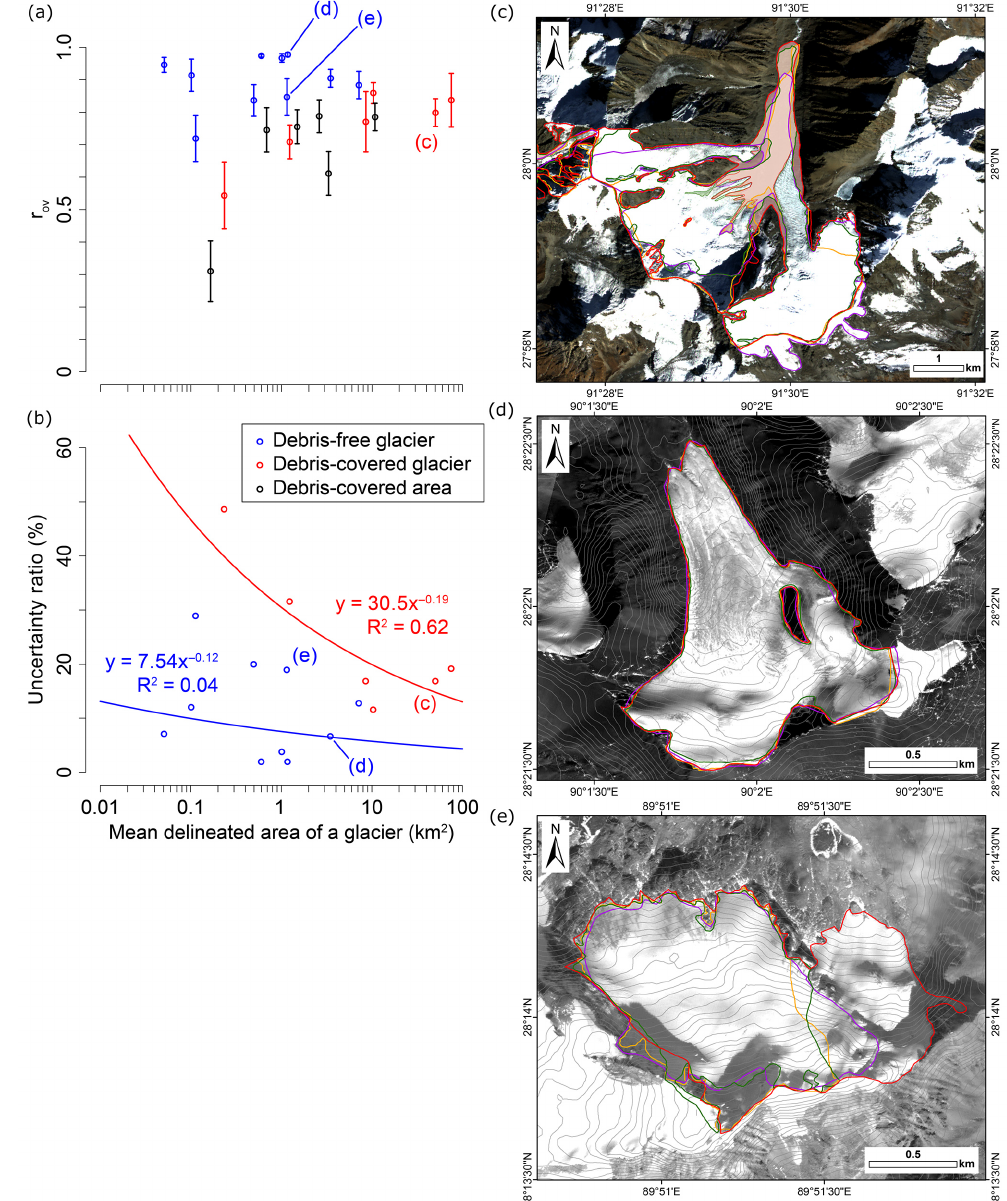
Figure 7. Validation of manual glacier delineation using ALOS imagery. (a) Mean values of r ov and their standard deviations, from six combinations among four outlines, are plotted against glacier area (or debris-covered area). (b) Deviations of glacier delineation in 16 sam- pled glaciers. (c) Debris-covered glaciers and debris-covered areas contain inconsistencies among four interpreters (coloured respectively), whereas (d) a simple shape of a debris-free glacier exhibits good consistency. (e) A debris-free glacier with steep slopes has inconsistencies on the higher parts of the outline (region in